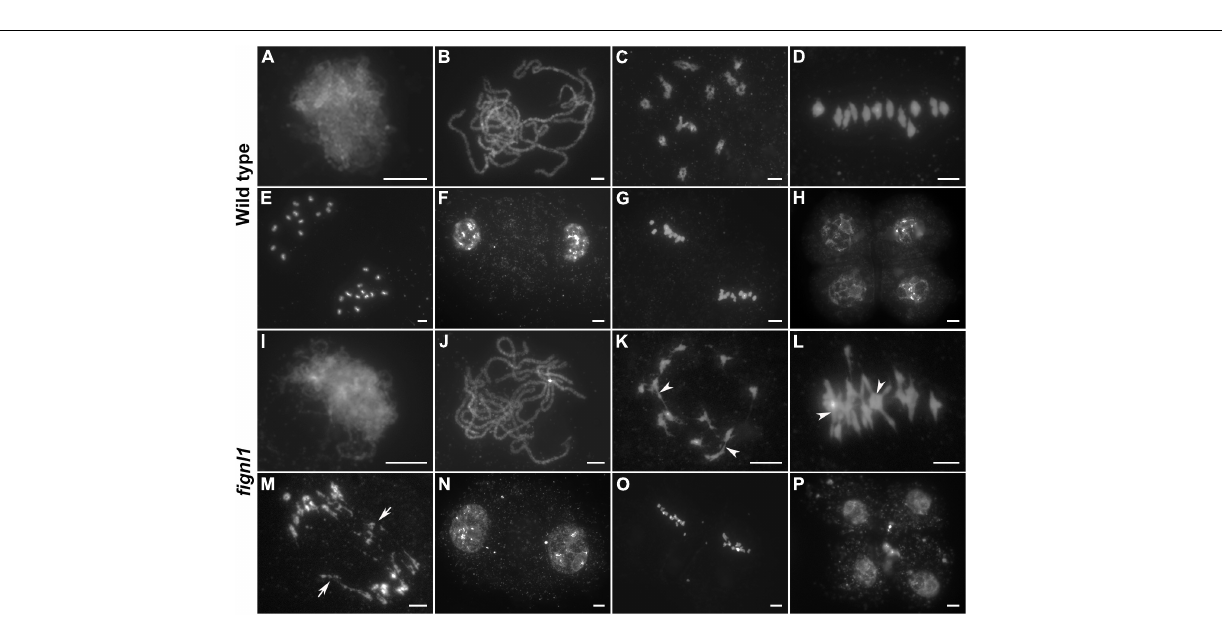
FIGURE 2 | Meiotic chromosome behaviors of pollen mother cells in wild type and fignl1 . Chromosomes were stained with DAPI. (A,I) Zygotene. (B,J) Pachytene. (C,K) Diakinesis. (D,L) Metaphase I. (E,M) Anaphase I. (F,N) Dyad. (G,O) Metaphase II. (H,P) Tetrad. Arrowheads point to some chromosome associations and arrows point to bridges. Scale bars, 5 µ